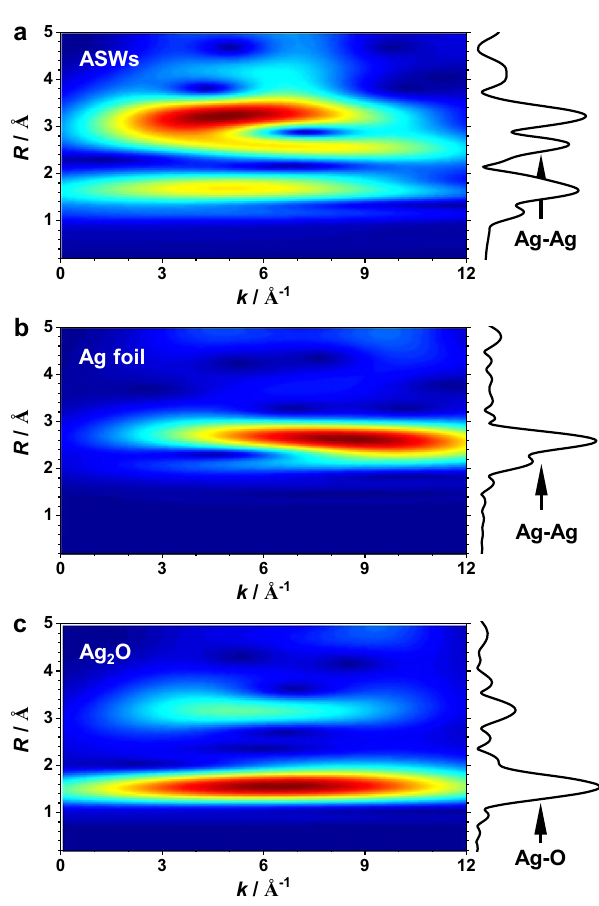
Fig. 1 Local structures of Ag atoms in ASWs. Wavelet transform plots and k 3 -weighted EXAFS spectra in R -space of Ag ( a ), ASWs ( b ), and Ag Color scale: dark blue to red refers to low intensity to high